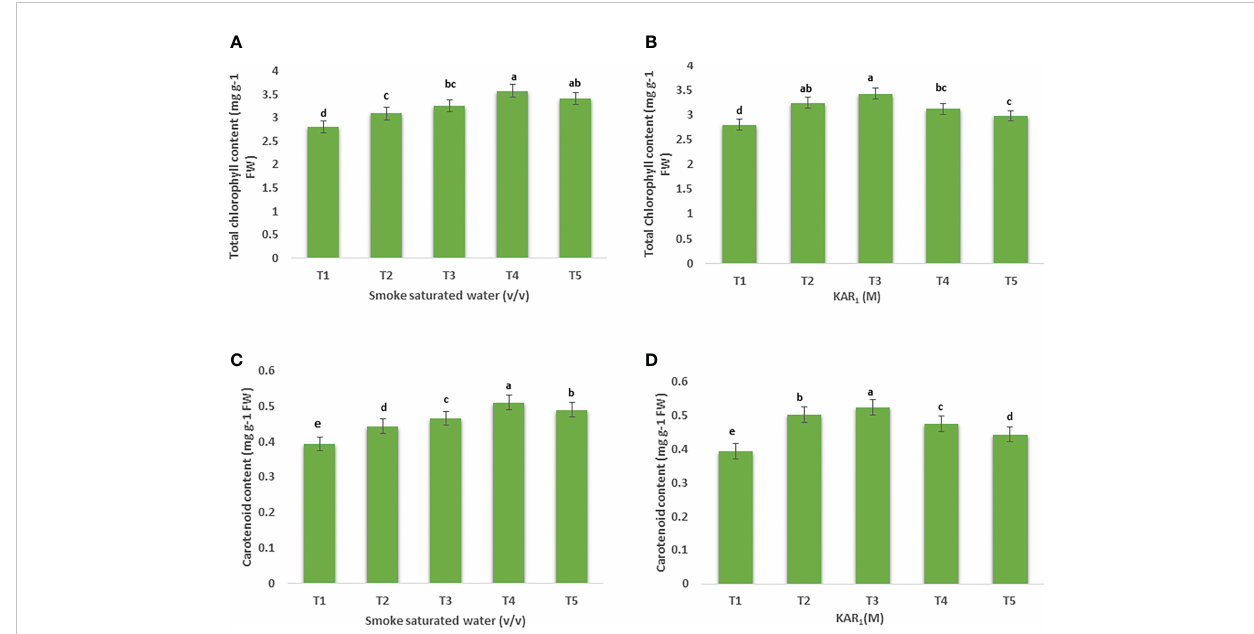
FIGURE 1 Effect of foliar application with smoke-saturated water 1:125, 1:250, 1:500, and 1:1000 v/v) and karrikinolide (10 -9 M, 10 -8 M, 10 -7 M and 10 -6 M) on total chlorophyll content (mg g -1 ) (A, B) total carotenoid content (mg g -1 ) (C, D) of Mentha arvensis L. Lowercase letters depicts the Duncan. Data are presented as treatments mean ± SE (n = 5). Data followed by the same letters are not signi fi cantly different by Duncan multiple range test at p ≤